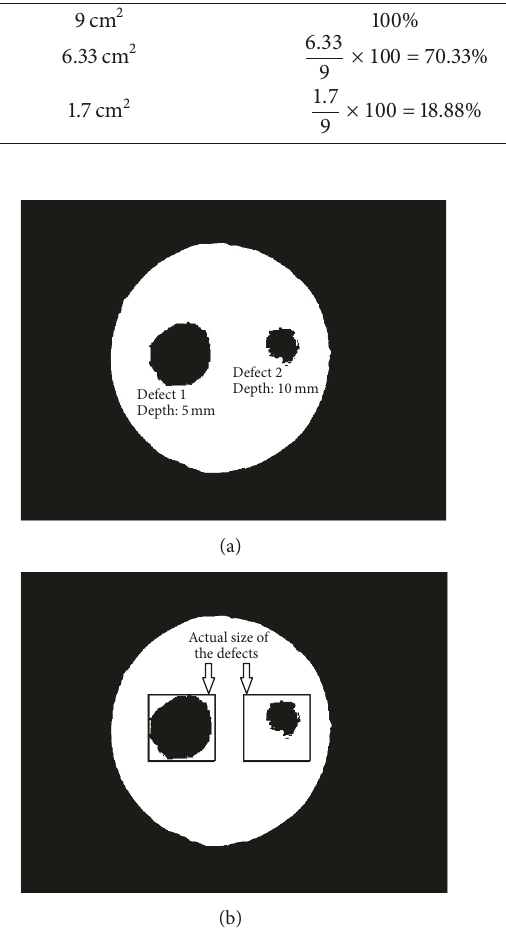
Figure 6: (a) Processed image using a 37 degrees of Celsius thresh- old. (b) A comparison between the actual size of the delamination and its size in the processed